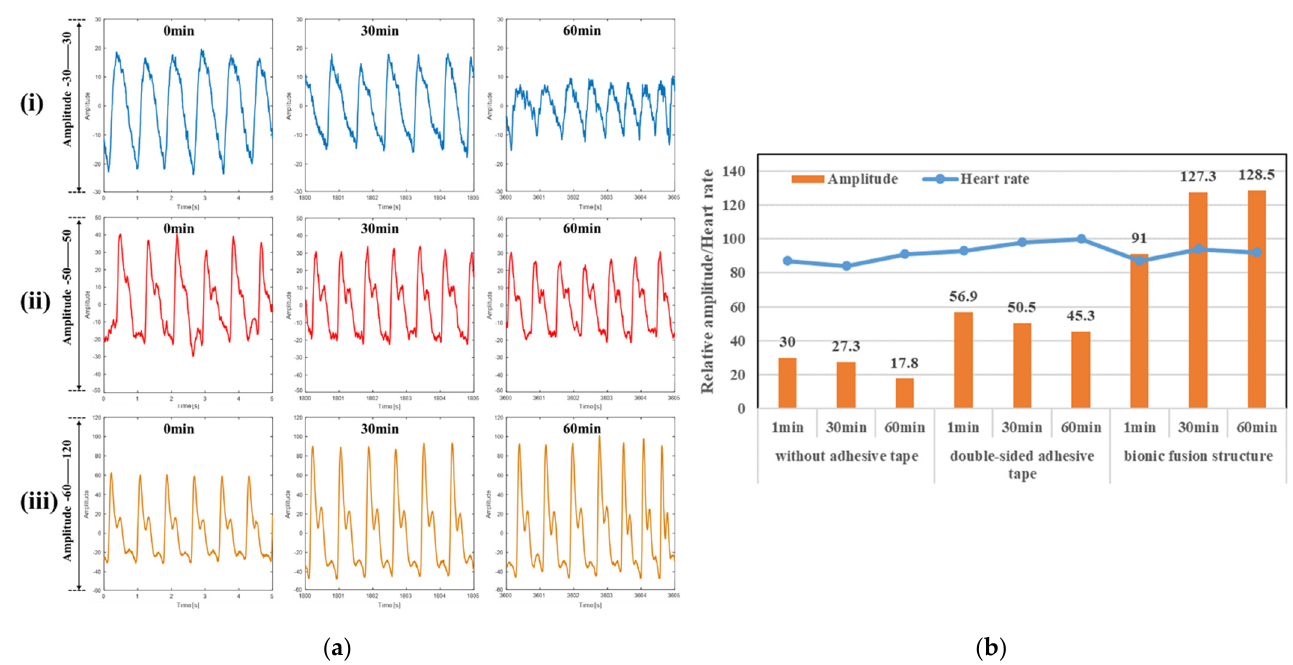
Figure 6. Pulse waveform and analysis of the rigid piezoelectric sensor at 0, 30 and 60 min under three kinds of attachment conditions: ( a ) The pulse waveform by the: i. direct measurement without adhesive; ii. with 3M strong double-sided adhesive; iii. with the biomimetic fusion structure self- adhesion; ( b ) Heart rate measurement results and amplitude contrast.